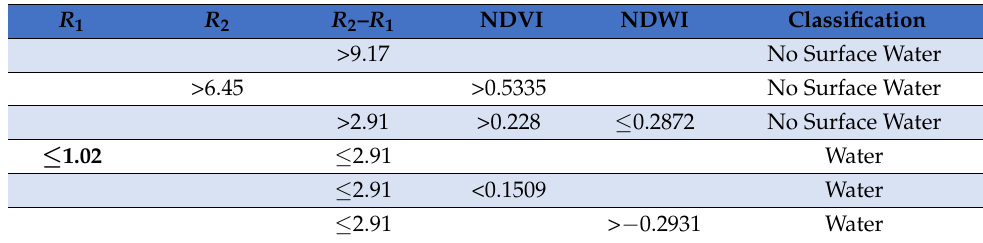
Table 2. Criteria to classify whether surface water is present in each grid cell based on reflectance, Normalized Difference Vegetation Index, and Normalized Difference Water Index derived from MODIS